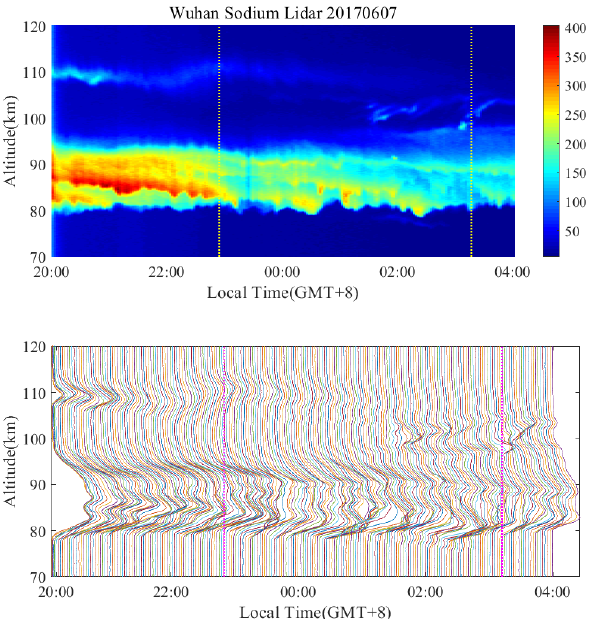
Figure 7. Simultaneous Na density measurements by the co-located Na lidar on 7 June, 2017. The two vertical lines in each plot mark the local time of the Na layer images in Figure 4.